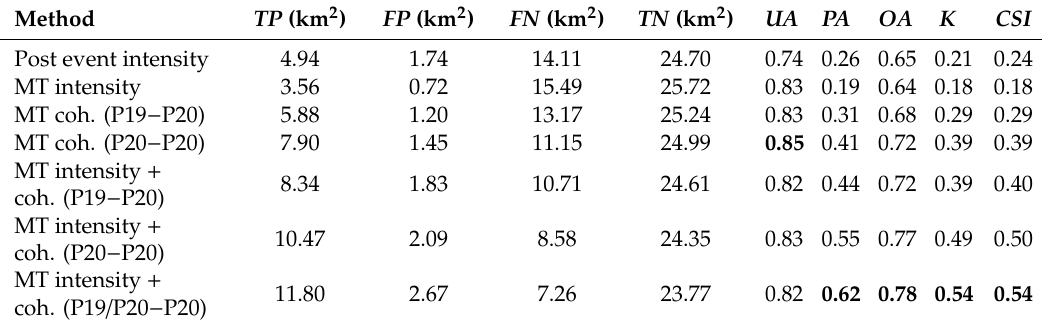
Table 2. Evaluation results of the flood